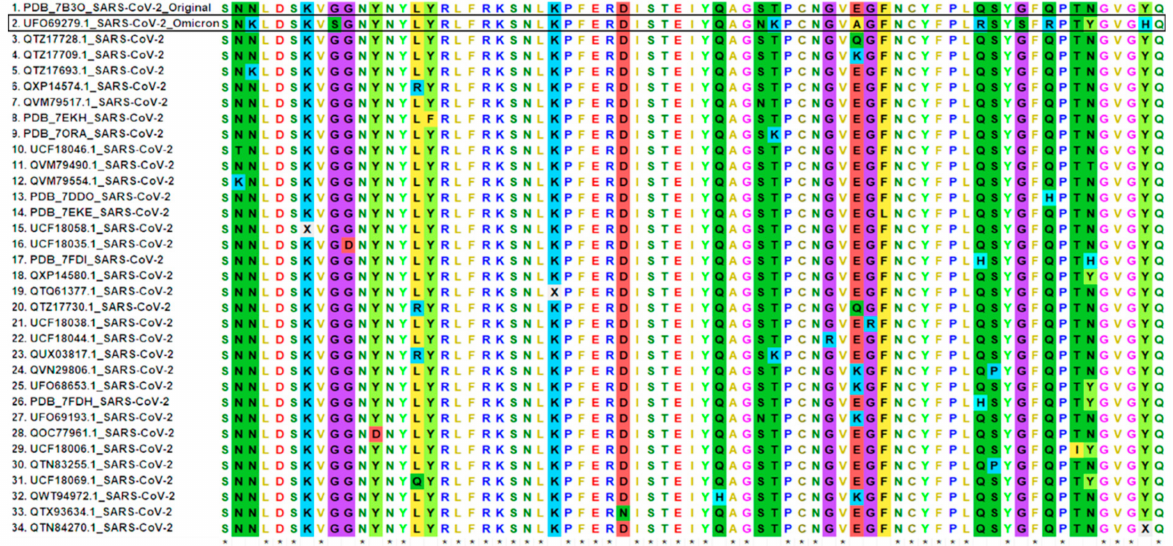
Figure 2. Comparative sequences analysis of the spike RBM of SARS-CoV-2. A total of 34 representa- tive sequences were aligned. Asterisks denote identical amino acid